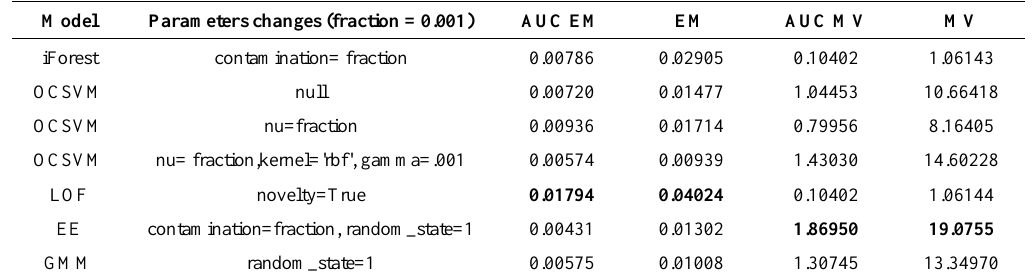
Table 3. Results for the novelty detection setting with PCA for ‘ec2_request_latency_system_failure’, where n_features=2.